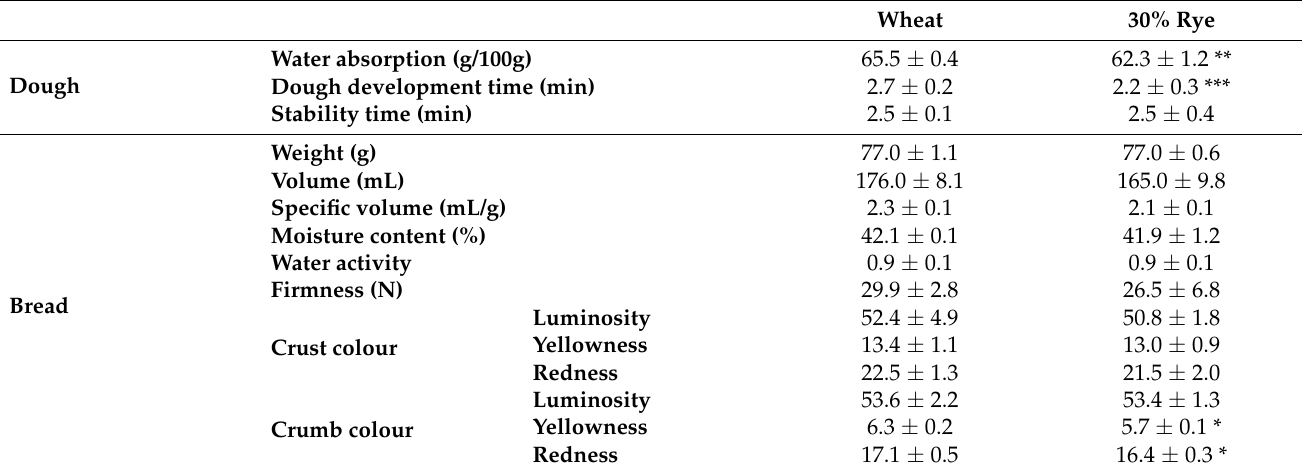
Table 4. Characterisation of dough and bread prepared from wheat flour and rye-wheat blend (30:70).